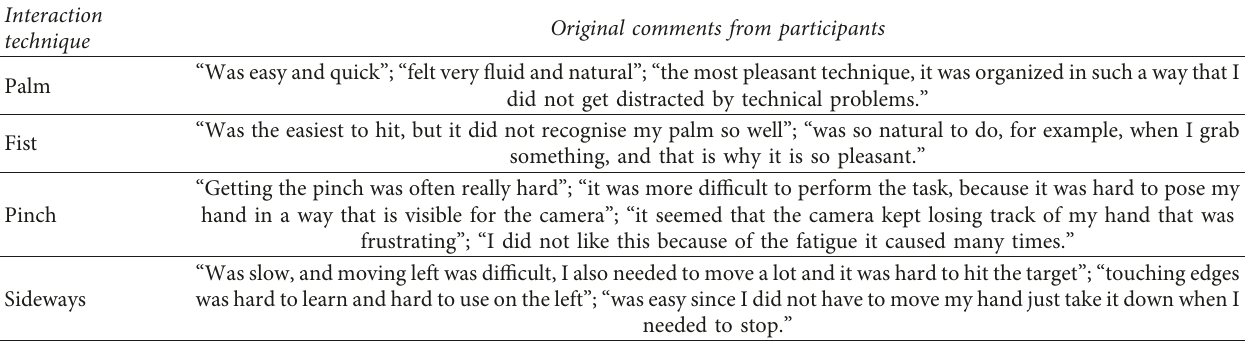
Table 7: Participants’ comments about the use of interaction